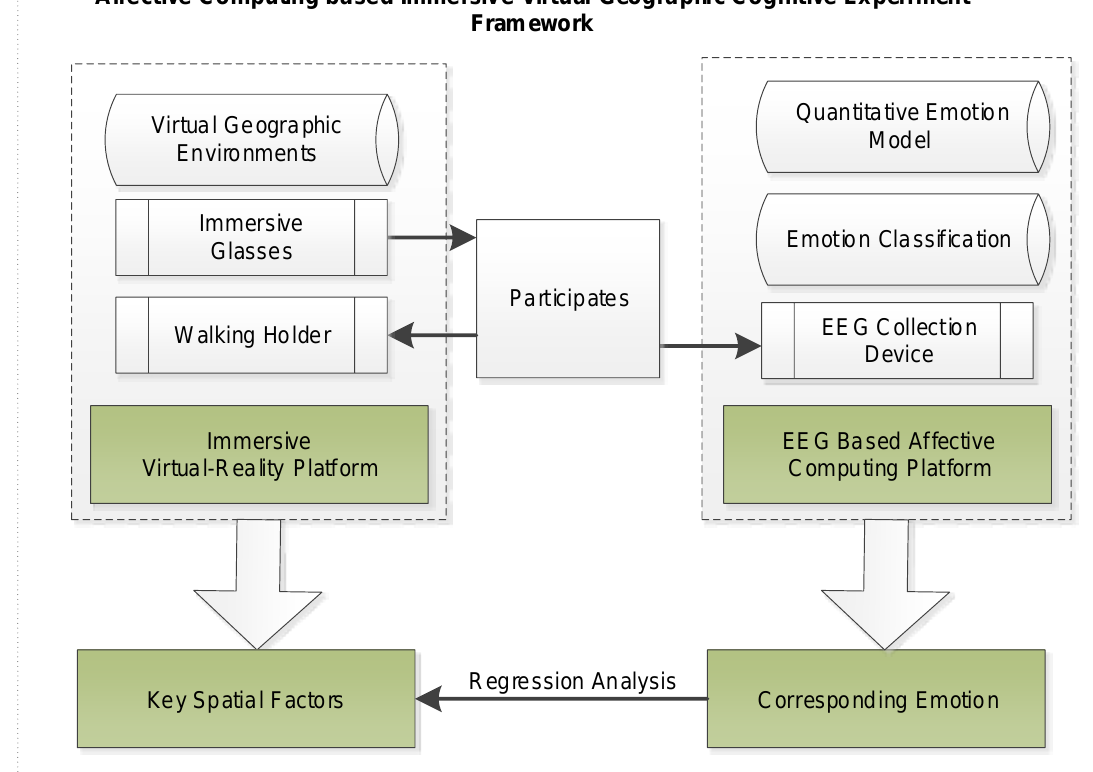
Figure 14. Affective-Computing-based Immersive Virtual Geographic Cognitive Experiment